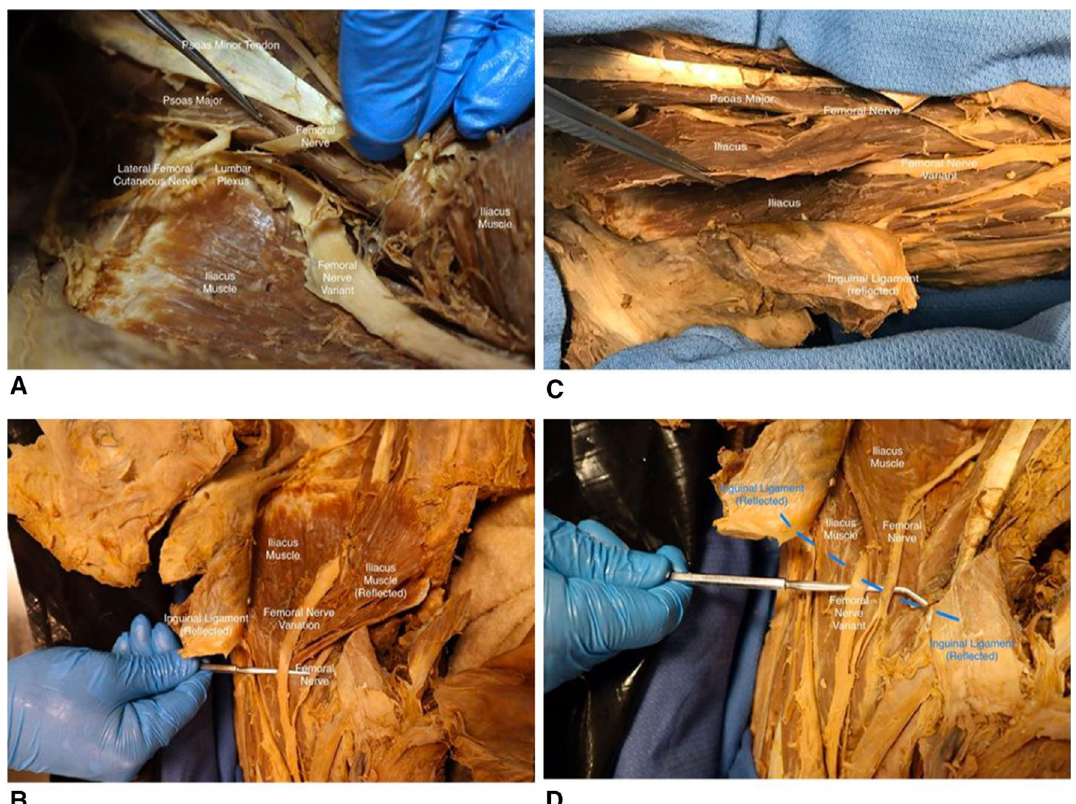
Fig. 2 a Right lumbar plexus showing origin of femoral nerve variant deep to the psoas major muscle, iliacus reflected to show variant femoral nerve. b Right femoral nerve variant piercing iliacus muscle and relationship. Inguinal ligament reflected to show merging of variant and typical femoral nerve tissue. c Variant femoral nerve emerging from iliacus and relationship with typical femoral nerve tract. d Variant femoral nerve emerging from iliacus and close association with inguinal ligament. Inguinal ligament path depicted in